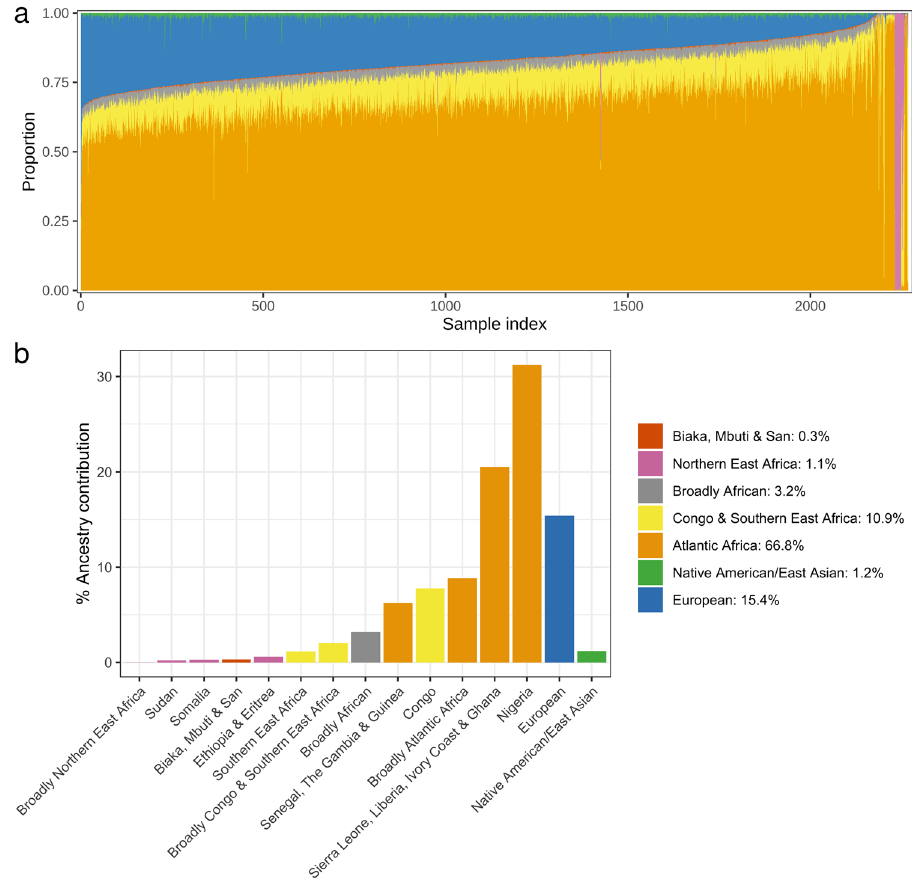
Fig. 1 The ancestry composition of the AFAM panel. a Estimated ancestry proportions for each of the 2,269 sequenced individuals in the AFAM panel. Only African regions and other regions that contributed substantially to admixture were included. Each column represents an individual colored by their respective estimated ancestry. Columns were ordered fi rst by cluster membership identi fi ed in Supplementary Fig. 2 and second by proportion of African ancestry. To ensure anonymity, each individual ’ s predicted ancestry proportions were multiplied by random numbers drawn uniformly from [0.9, 1.1] and the resulting values were normalized to sum to 1. b Average percentage of ancestry contribution across the entire AFAM panel for 13 different African regions and the two largest non-African admixed contributions (European and Native American/East Asian). Individual ancestry contributions were estimated by the 23andMe ancestry classi fi